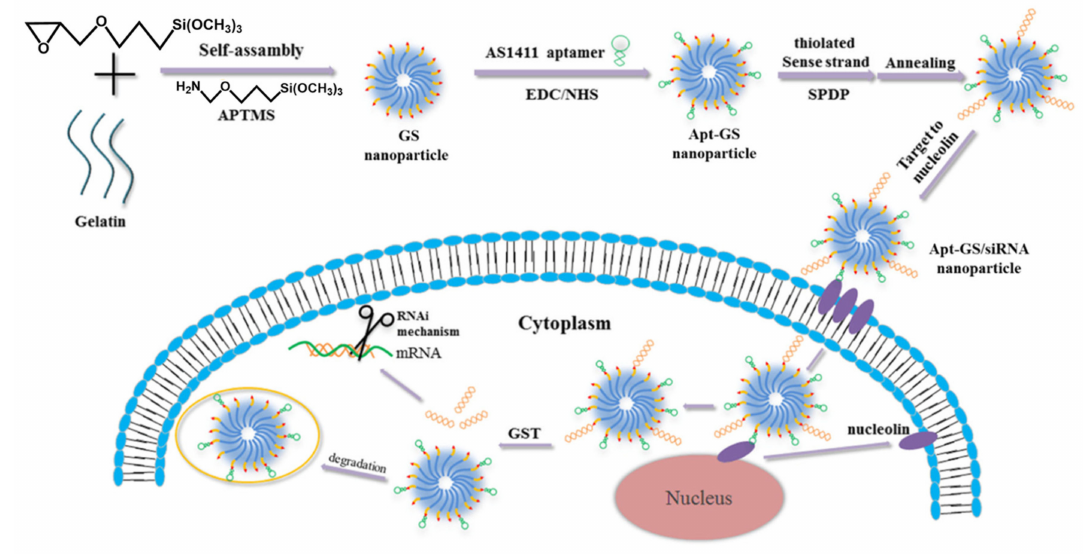
Figure 3. Scheme of the redox-responsive tumor-targeting Apt–gelatin–silica nanogels (GSNGs) developed for siRNA by Zhao et al. Reproduced from [22], Springer Nature,